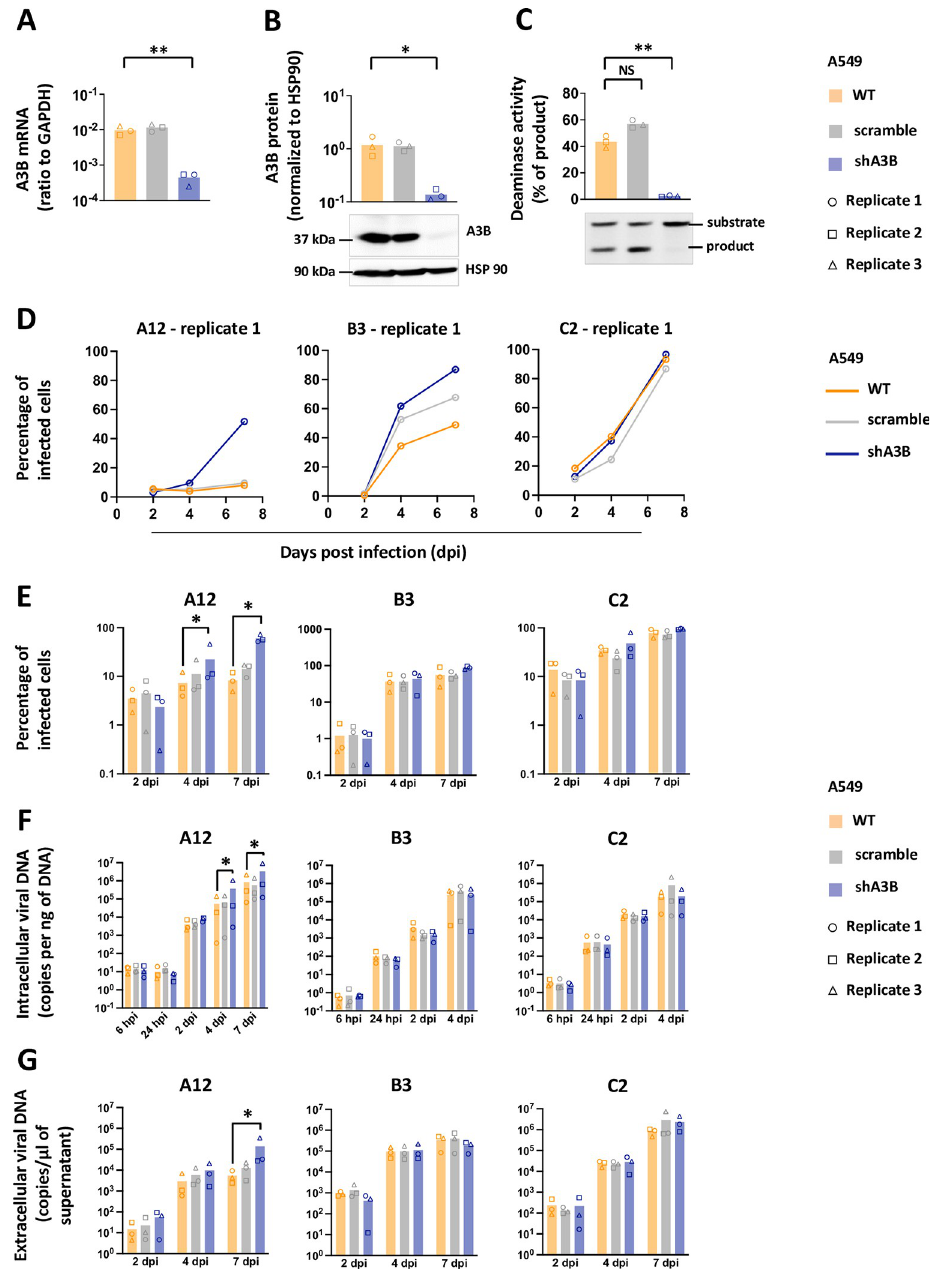
Fig 5. A3B knockdown promotes replication of strain A12. A549 lung cancer cells were transduced to stably express APOBEC3B-targeting shRNAs (shA3B) or a nontargeting control shRNA (scramble). (A) A3B mRNA levels were quantified by RTqPCR and expressed relative to GAPDH mRNA. (B) A3B protein levels were assessed by western blot, quantified by densitometry and normalized with HSP90. (C) Deamination activities of the cell lysates were expressed as the percentage of substrate converted into product and compared to the deamination activity of the WT cells. P- values were calculated by t-tests. (D-G) A549-WT, -scramble and -shA3B were infected with HAdV-A12, -B3 or -C2 at a MOI = 0.03 and analyzed at different time points post infection. (D-E) The percentage of infected cells were quantified by flow cytometry. The results of the first replicate are shown in panel D and the data from the 3 replicates are shown in panel E. Intracellular viral DNA levels (F) and extracellular viral DNA levels (G) were quantified by qPCR. P-values were calculated by ratio t-tests. Only significant differences are shown.